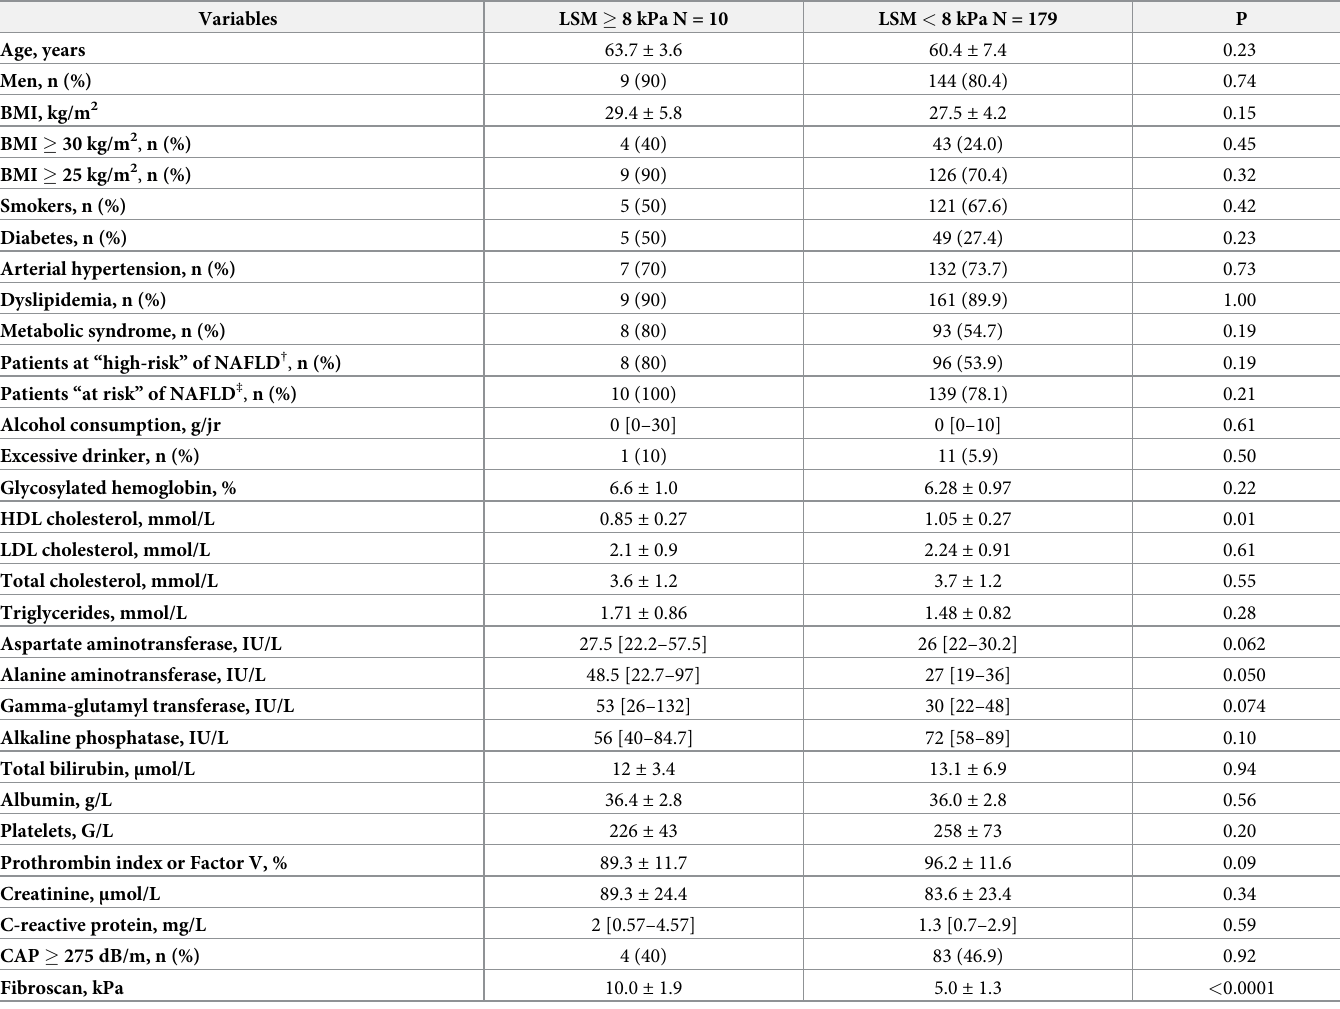
Table 2. Biological and demographic characteristics of patients according to liver